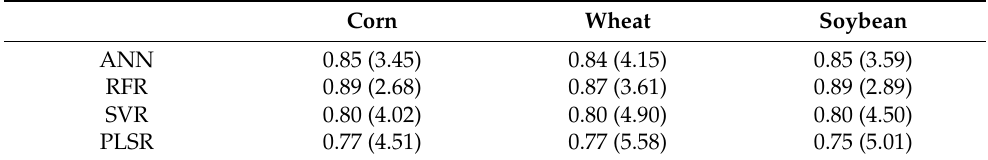
Table 3. R 2 (RMSE) between the actual and modeled values of the RCF based on different machine learning algorithms, considering spectral indices and radar bands as dependent variables.